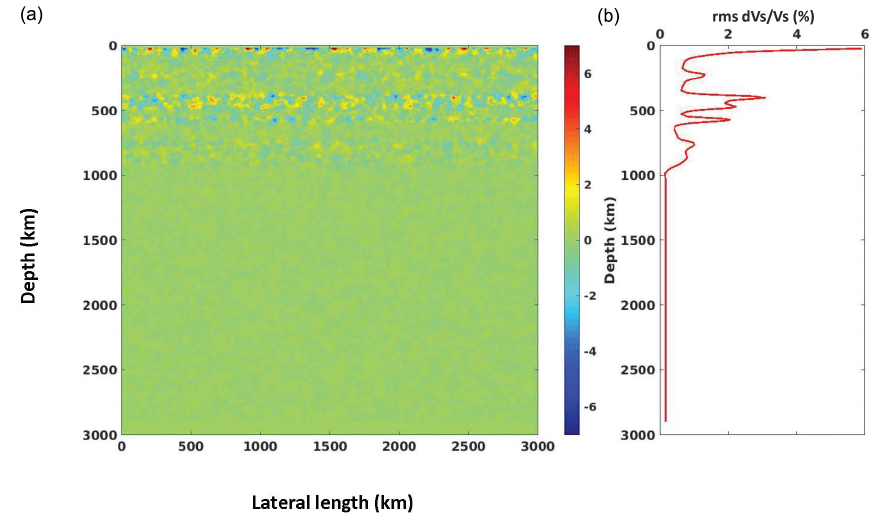
Figure 2. (b) Depth-dependent rms shear velocity perturbation profile applied in MODEL 3 vs. perturbation values from crust to 1000km depth extracted from the stochastic tomography result of Cormier et al. (2019). (a) 2-D representation of the same depth-dependent profile. Compared to MODEL 2, note the additional peaks in heterogeneity power associated with phase transitions in the upper